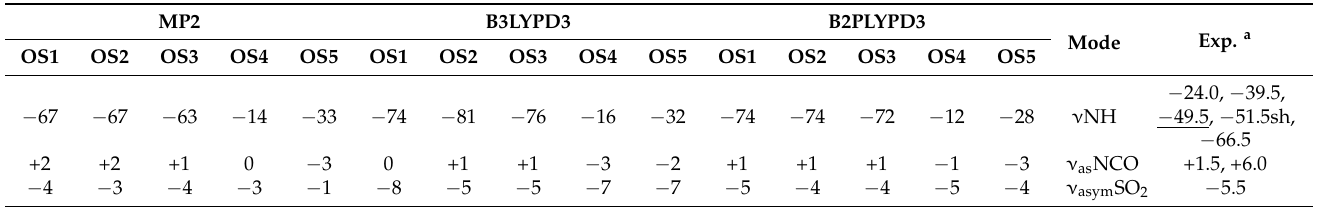
Table 4. Selected wavenumber shifts calculated for the 1:1 complexes using the MP2, B3LYPD3 and B2PLYPD3 methods with basis set 6-311++G(3df,3pd) compared to the experimental